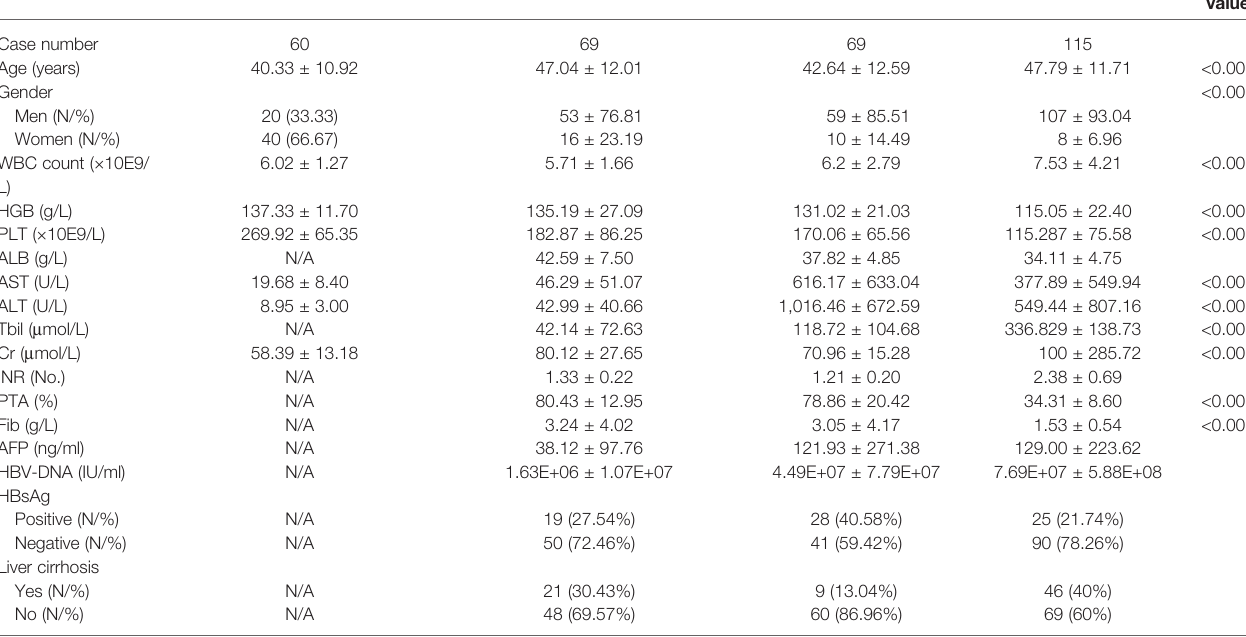
TABLE 1 | Demographics and clinicopathologic characteristics of